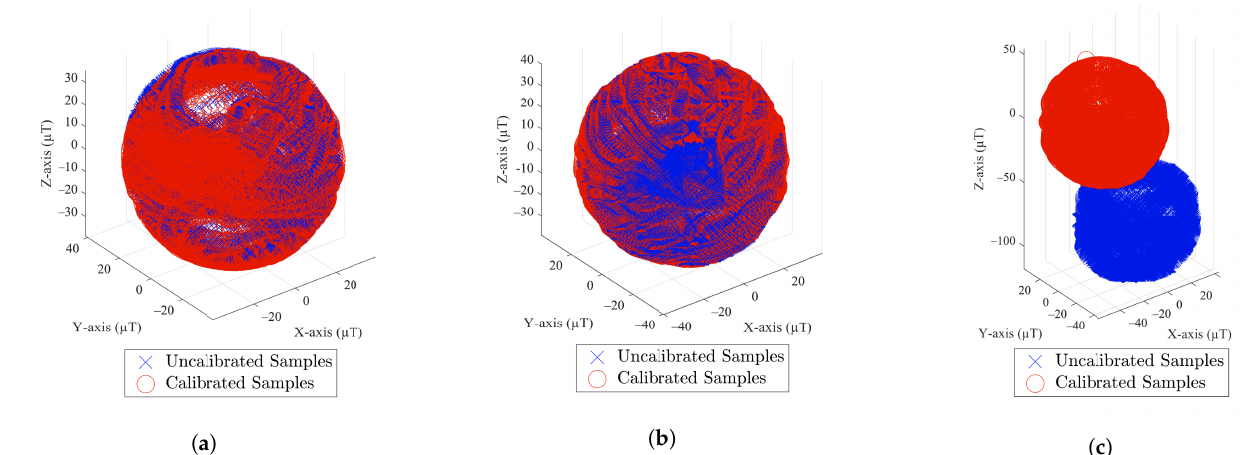
Figure 10. Smartphone calibration test: ( a ) iPhone Xs Max; ( b ) Huawei P9; ( c )